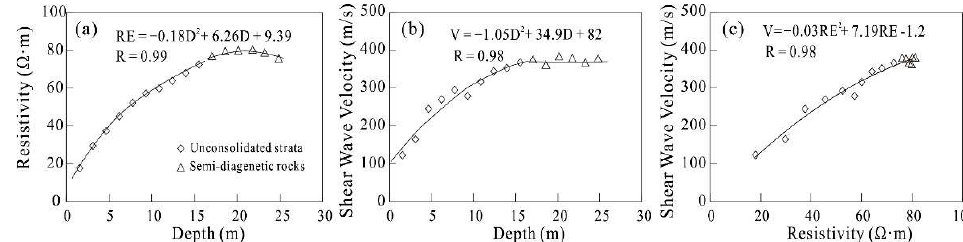
Figure 7. Electrical resistivity versus depth, shear wave velocity versus depth, and electrical resistivity versus shear wave velocity.